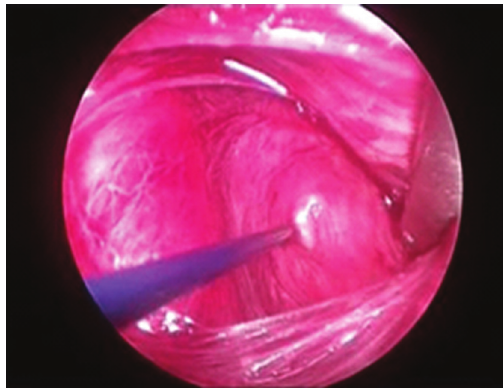
Figure 1: Intra operative nerve monitoring of right recurrent laryngeal nerve.